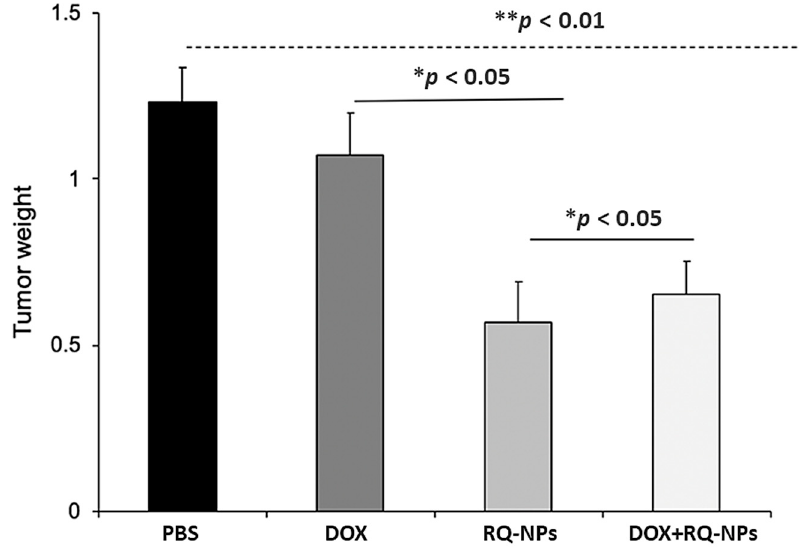
Figure 4. Effect of DOX + RQ-NPs, doxorubicin (DOX), and their combination on tumor weight (g). Values are expressed as the mean ± SEM. * p < 0.05, ** p < 0.01.